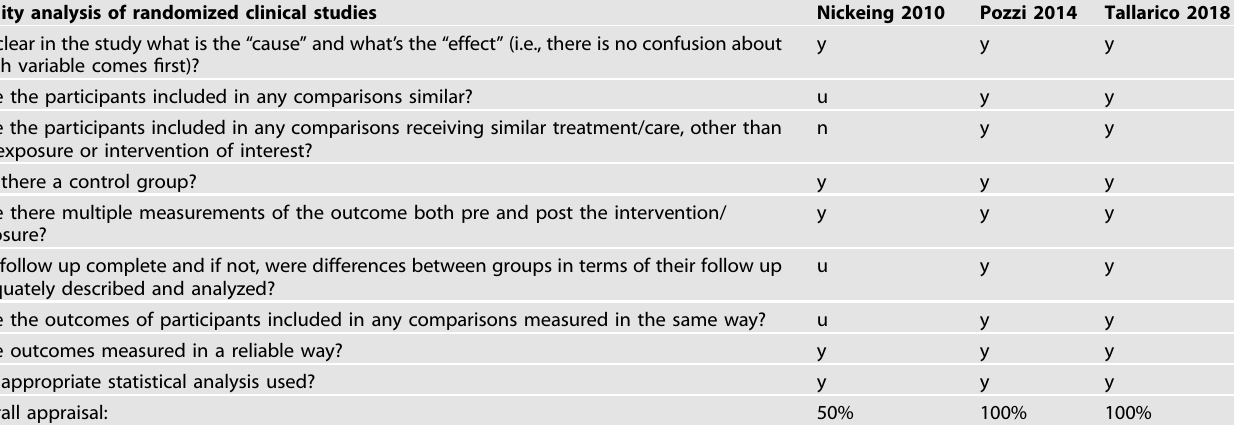
Table 2. Individual risk of bias assessment for controlled randomized studies: review authors ’ judgments about each risk of bias factor among the selected